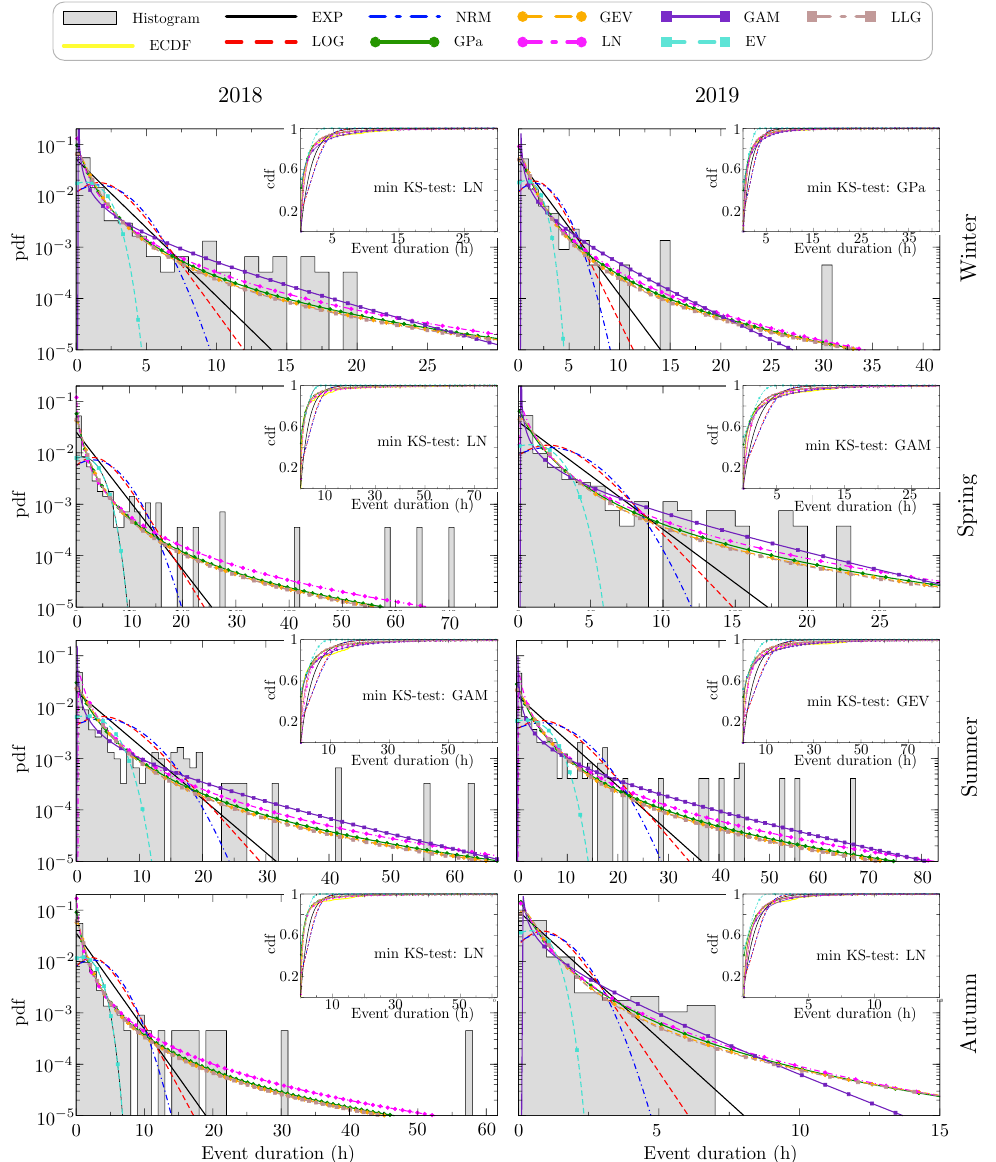
Figure 8. Probability density functions of fog events over time for the L-moments approach establish- ing the threshold at 300 m. The CDF is located in the insets. Each row corresponds to a season and each column to a